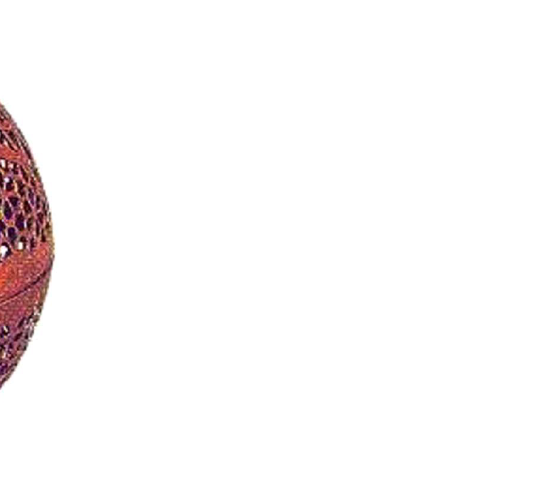
Figure 7. Spherical Censer. Ming dynasty, bronze. Height: 12.8 cm; diameter: 13.3 cm. National Museum of China.